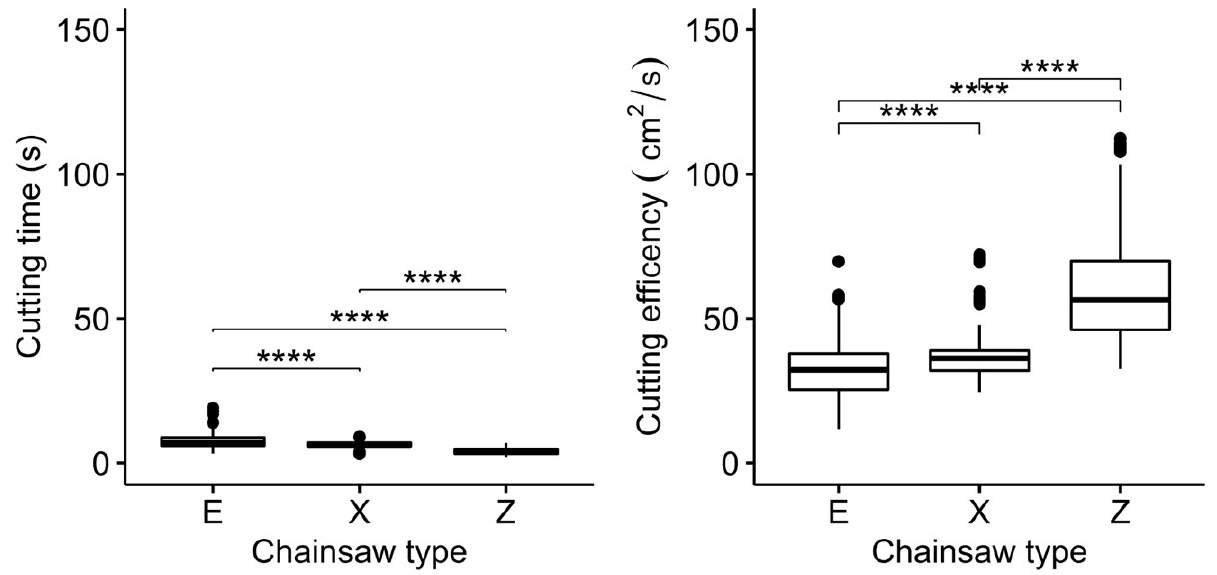
Figure 2. Results of the Wilcoxon test with Bonferroni adjustment applied to each chainsaw type. The median and spreading-range values of the cross-cutting times are represented in the left graph and the median and spreading-range values of the cutting efficiency on the right graph (N = 270). The significance of the pairwise comparison is reported using brackets. p -level: **** = 0.0001. Table 3. Results of measured cutting times. Mean, maximum, minimum, median and SD values for each wood species and chainsaw tested (E—MSA 220 C-B; X—MS 201 C-M; and Z—MS 261 C-M). Numbers in bold represent the highest values per wood species, with the highest values overall in red, and the lowest values in